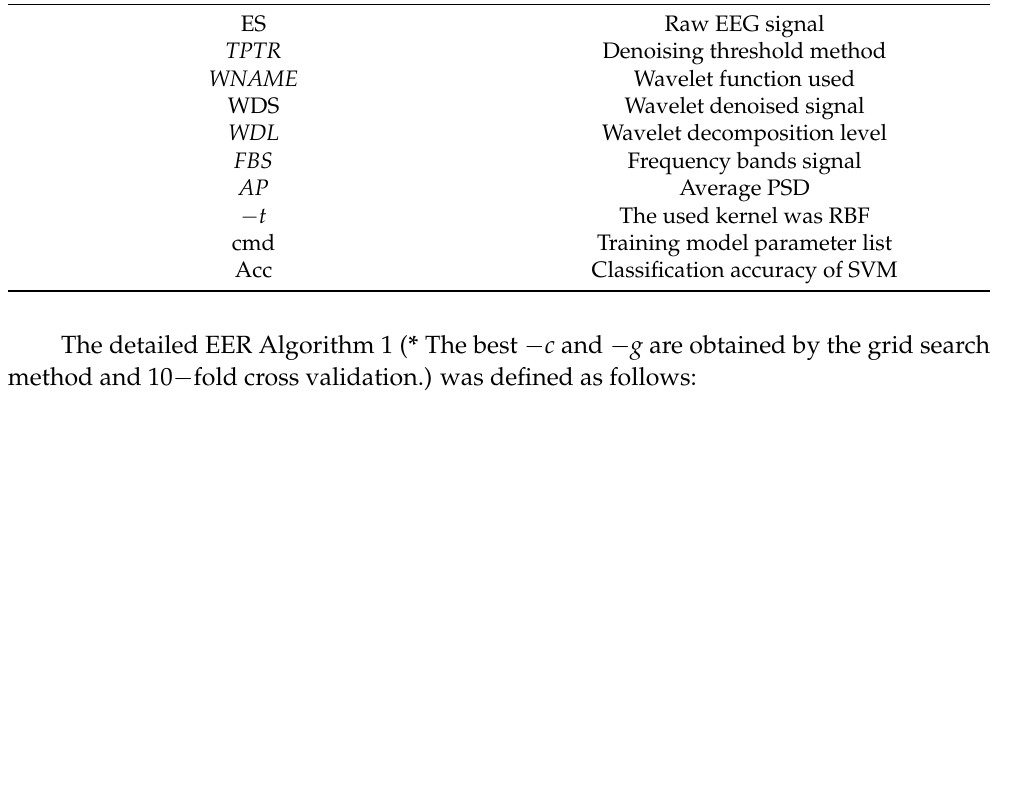
Table 2. Notations for EER algorithm.